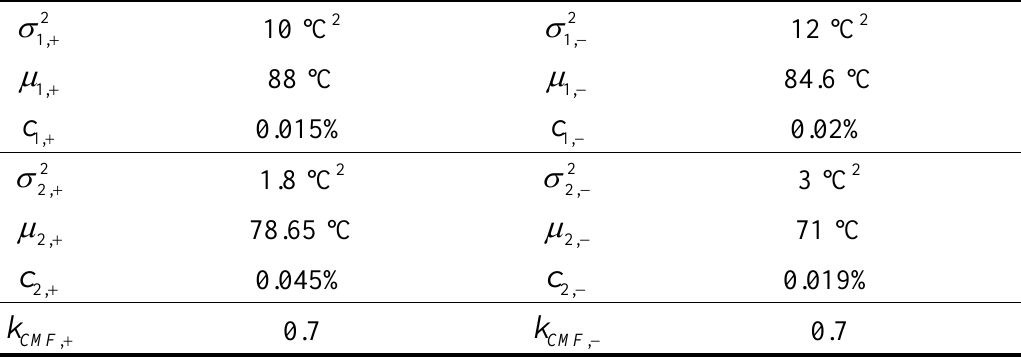
Table 1. Parameters for SMA hysteresis